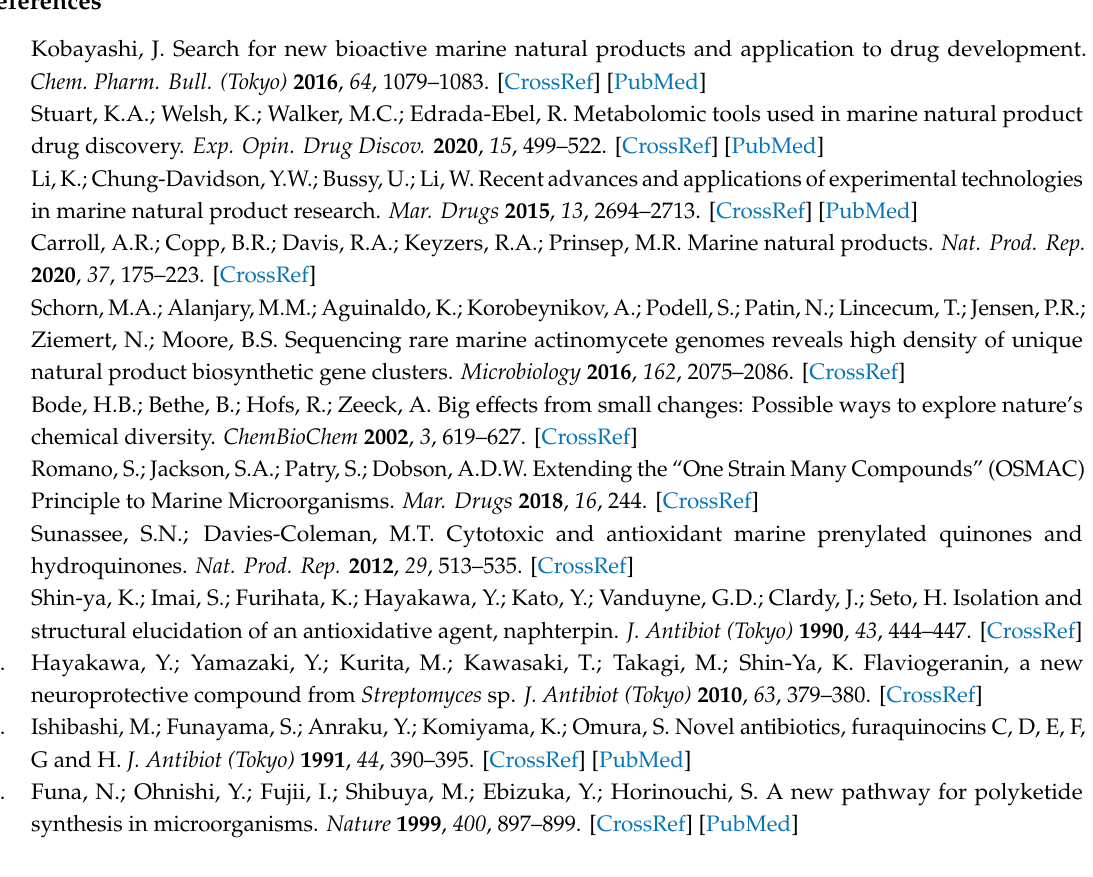
Figure S1: HPLC profile of Streptomyces sp. B9173 metabolites in MS media, Figure S2: Sequence alignment of the type III PKS from gene clusters of naphthoquinone-containing compounds, Figure S3: NMR spectra of flaviogeranin B1 ( 1 ) , Figure S4: NMR spectra of flaviogeranin B ( 2 ), Figure S5: NMR spectra of flaviogeranin D ( 3 ), Figure S6: 1 H NMR spectrum of flaviogeranin C1 ( 4 ), Figure S7. 1 H NMR spectrum of flaviogeranin C2 ( 5 ), Figure S8. 1 H NMR spectrum of flaviogeranin A1 ( 6 ), Figure S9. 1 H NMR spectrum of flaviogeranin A ( 7 ); Figure S10. CD spectrum of flaviogeranin D; Table S1. HR-ESI MS of known compounds 4 - 7